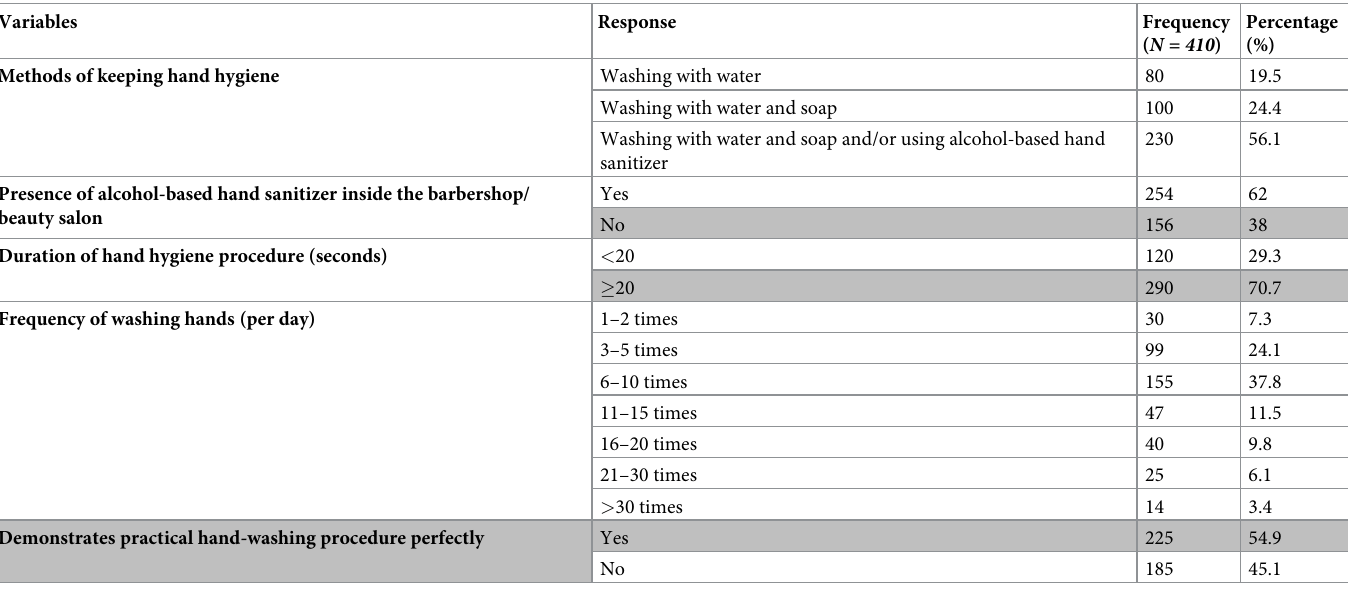
Table 4. Hand hygiene practice-related factors among barbers and beauty salon workers in Dessie City and Kombolcha Town, Northeastern Ethiopia, January 5 to February 10, 2021.